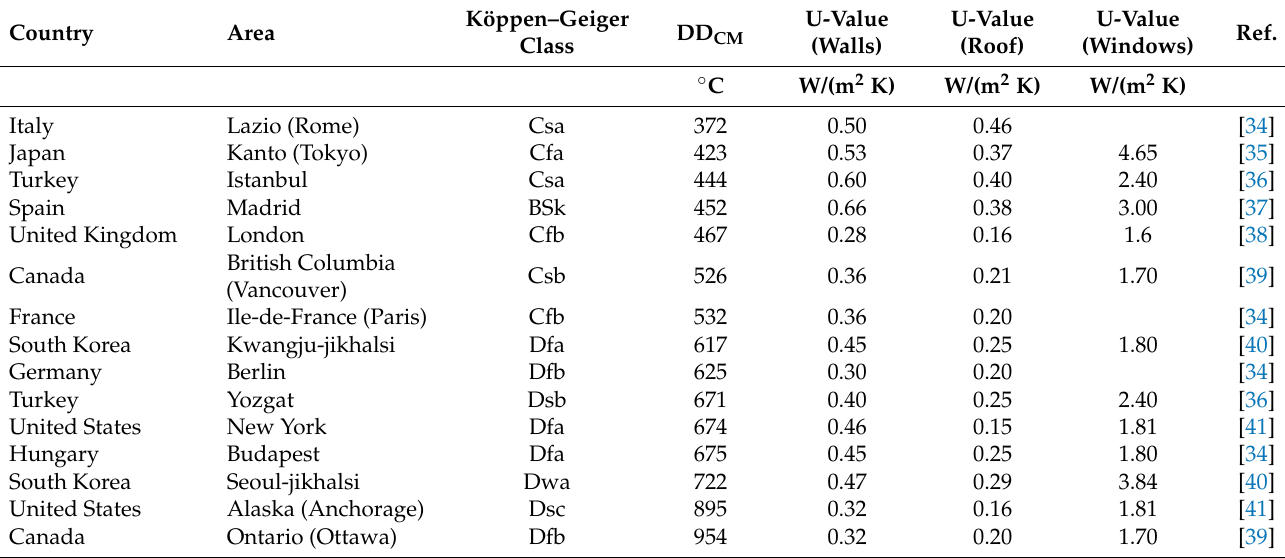
Table 1. Some of the cities studied, Köppen–Geiger classification, and U-values for representative construction elements.